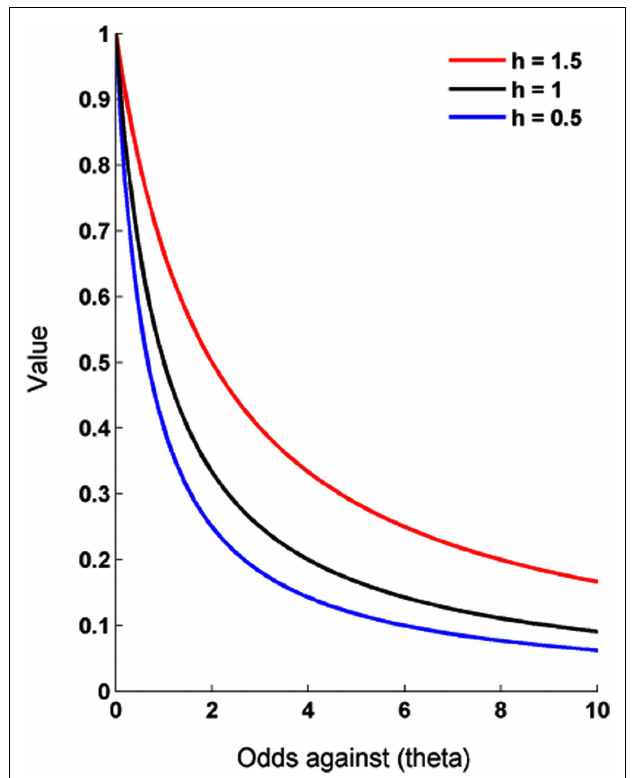
FIGURE 2 | Hyperbolic discounting of risk. In this basic hyperbolic model individuals steeply discount reward value with initial decreases in probability of occurrence and only gradually as they get more unlikely. h is a risk aversion parameter. In the case of h = 1 discounting conforms to EU theory, i.e., an equal decrease in value for every percent decline in probability. h < 1 equates to risk aversion and when greater than one to risk seeking.Value here is represented as a proportion of its initial (certain) value or alternatively as the discount